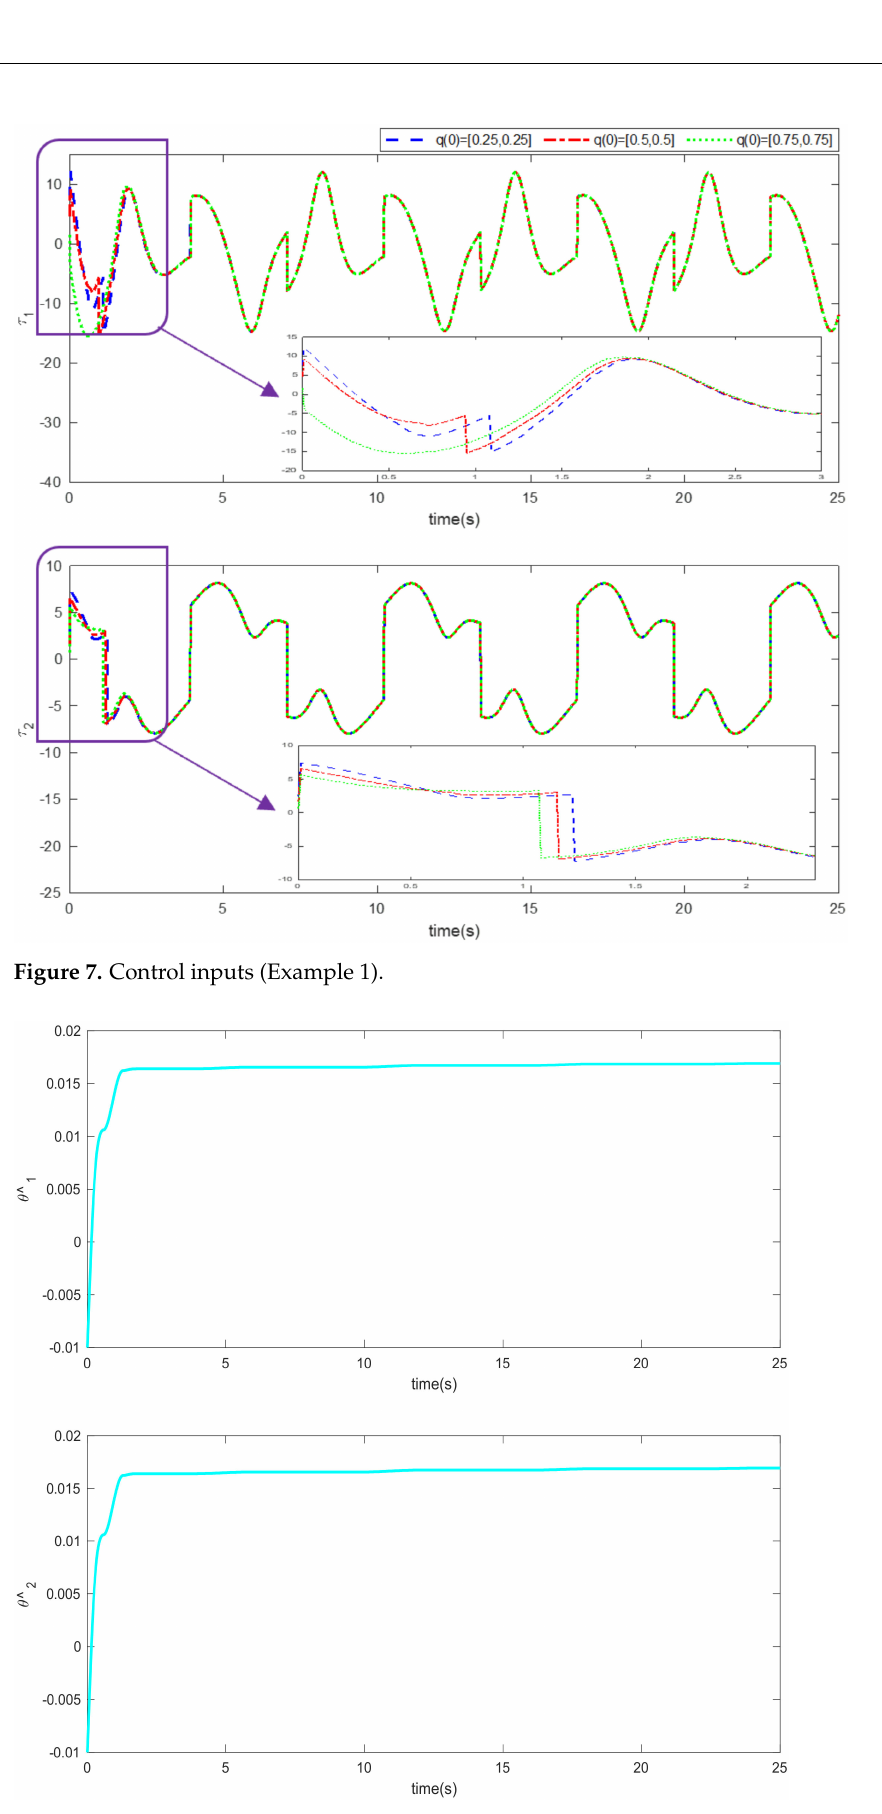
Figure 8. Adaptation law based on neural network (Example